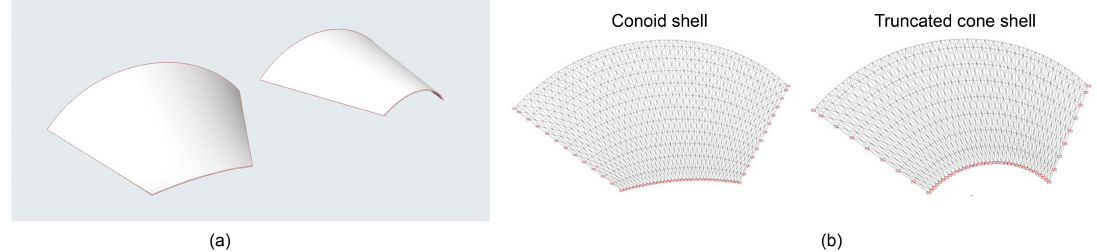
Figure 6: Export models in ArchiCAD to SCAD